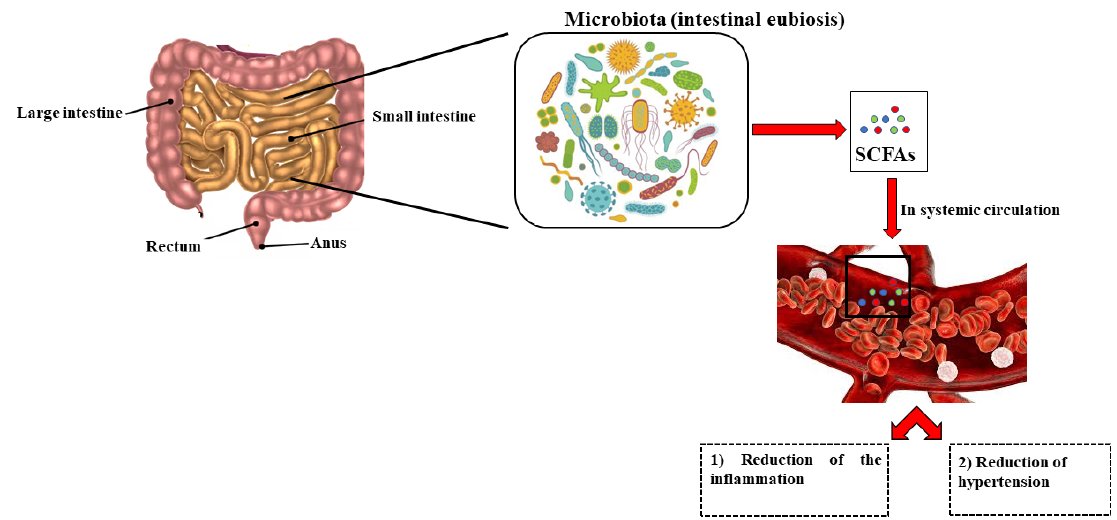
Figure 4. Protective role of the gut microbiota.